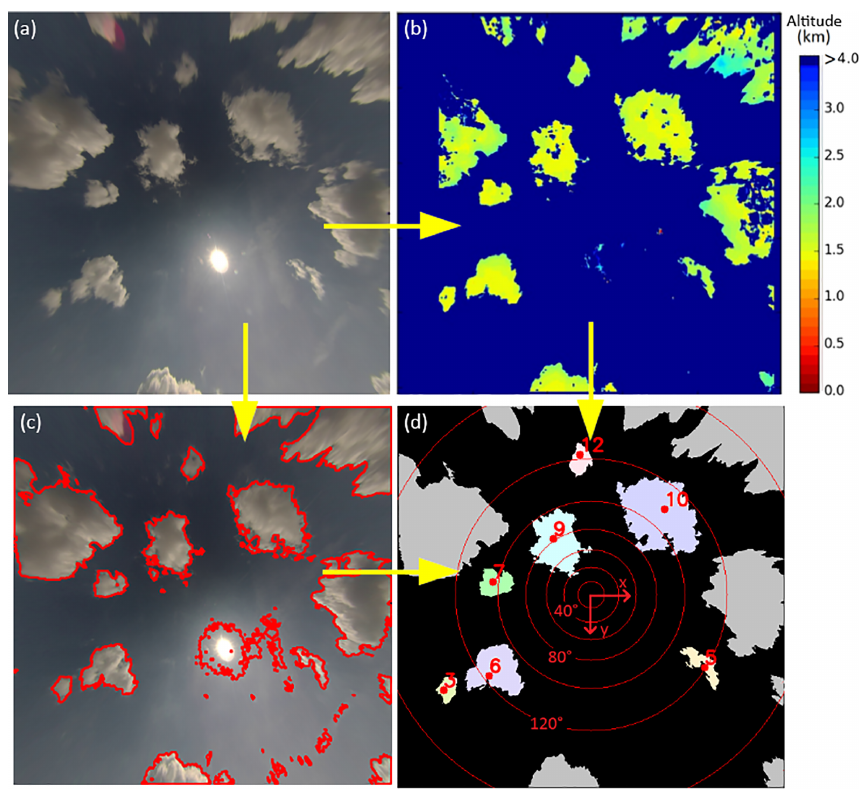
Figure 15. (a, b) Undistorted and rectified left image with associated height map. (c) Contours produced by blue filtering segmentation on left rectified image. (d) Segmented image with cloud identification number and estimated position of center of cloud base (red dots). Altitude filter: